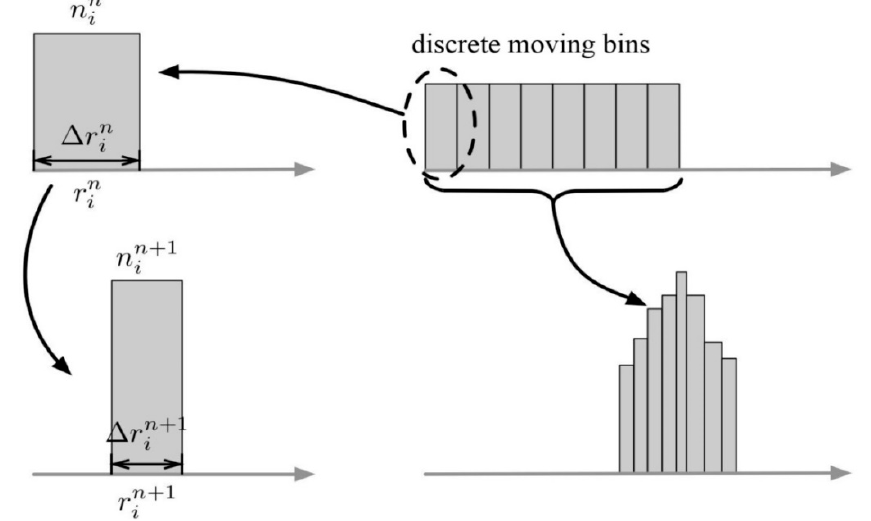
Figure 1. Diagram of the time evolution of the discrete moving bins ( n (cid:2919)(cid:2924) = n (cid:2919)(cid:2924)(cid:2878)(cid:2869) , where the superscript n of n (cid:2919) is from the timestep n to n + 1).